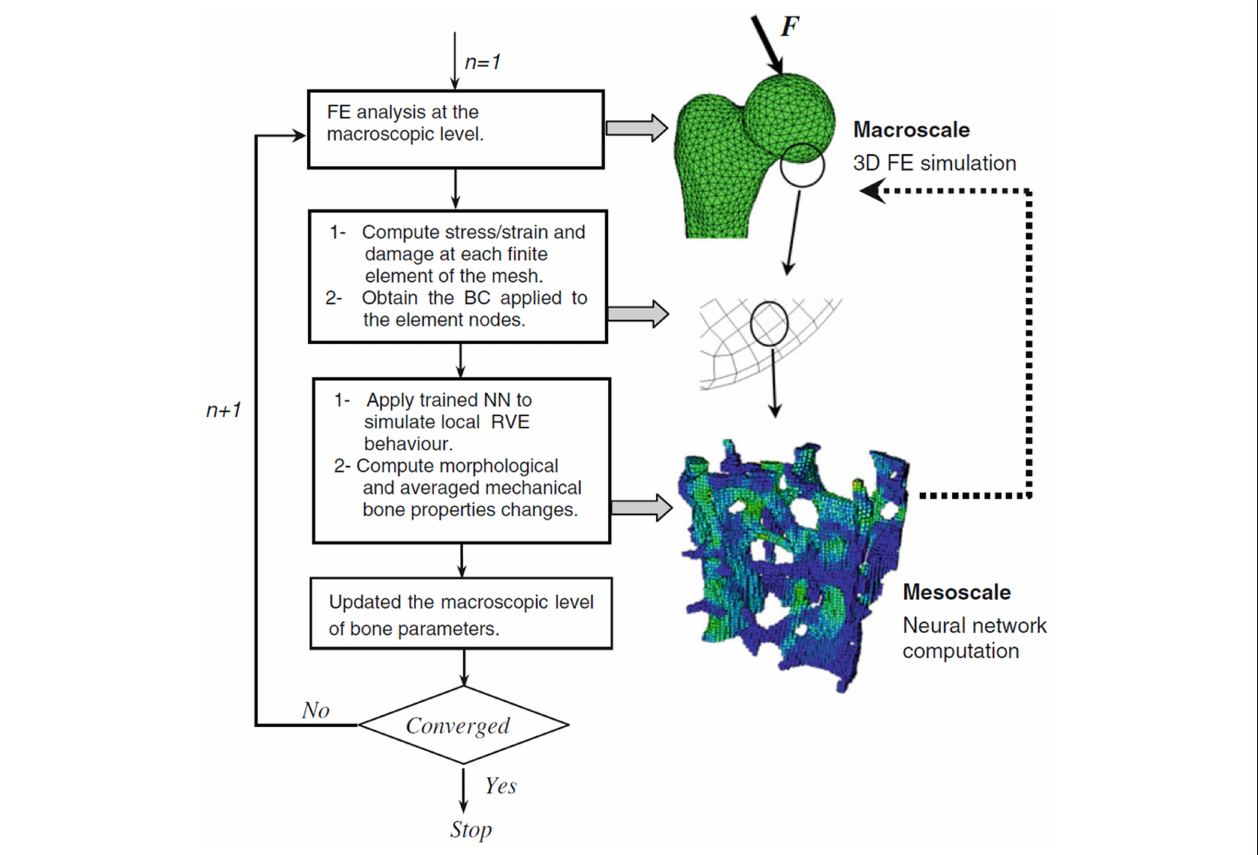
FIGURE 9 | Multiscale finite element neural network (FENN) approach for bone analysis: two-level analysis for predicting the remodeling process. Macroscale level: whole bone computed using FE analysis. Mesoscale level: effective properties of trabecular bone structure computed using a trained neural network. Reprinted from Hambli et al. (2011), Copyright (2010), with permission from Springer